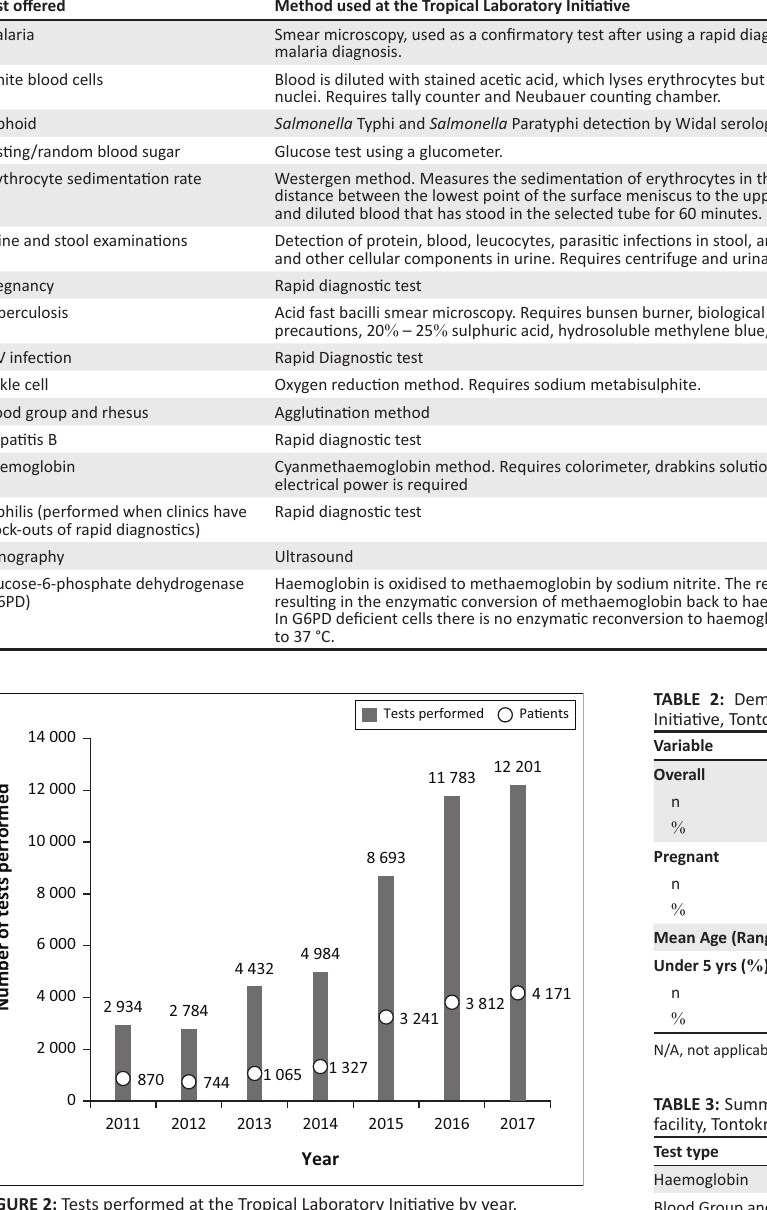
TABLE 1: Diagnostic tests offered at the Tropical Laboratory Initiative site in Tontokrom, Ghana, July 2019. Test offered Method used at the Tropical Laboratory Initiative Malaria